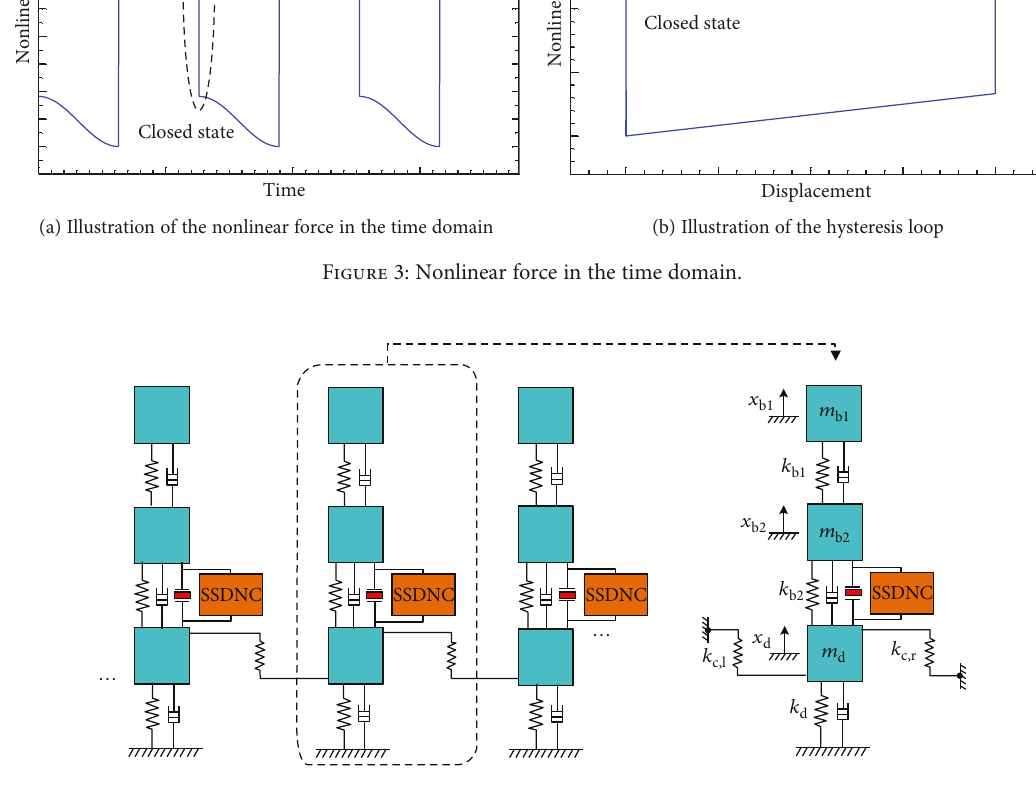
Figure 4: Nonlinear